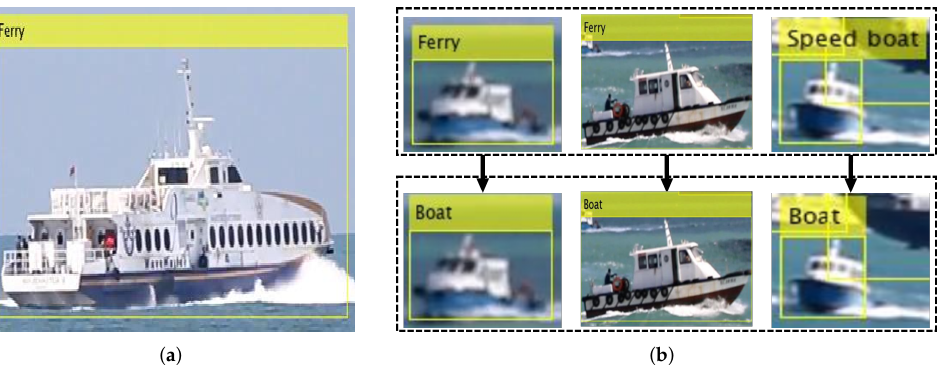
Figure 3. Example of noisy label correction in the SMD: ( a ) A typical image for ‘Ferry’, ( b ) Noisy labels in the top and their corrected ones at the